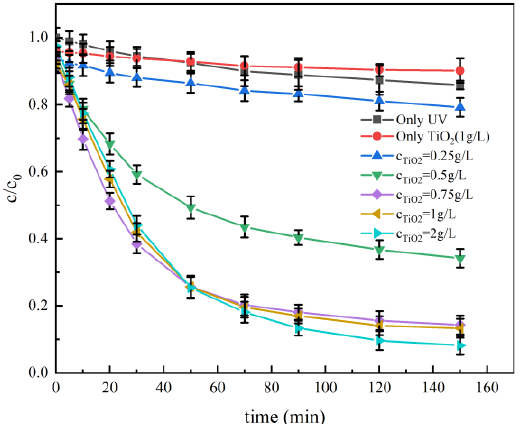
Figure 9. Evolution of concentration with four TiO 2 concentrations at a wastewater temperature of 20 °C and AR 26 initial concentration of 45 mg/L.